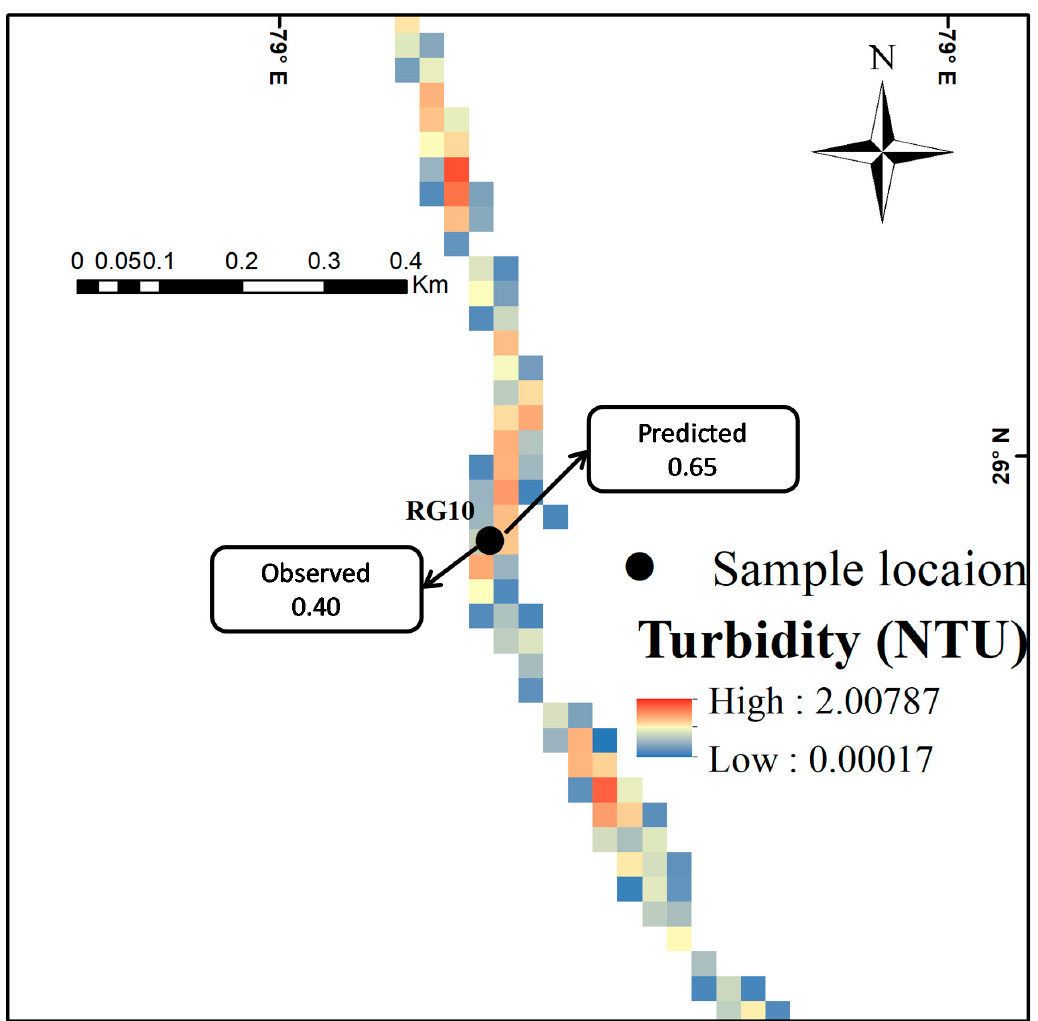
Figure 9. Turbidity map of theRamganga River on 11 November 2014.